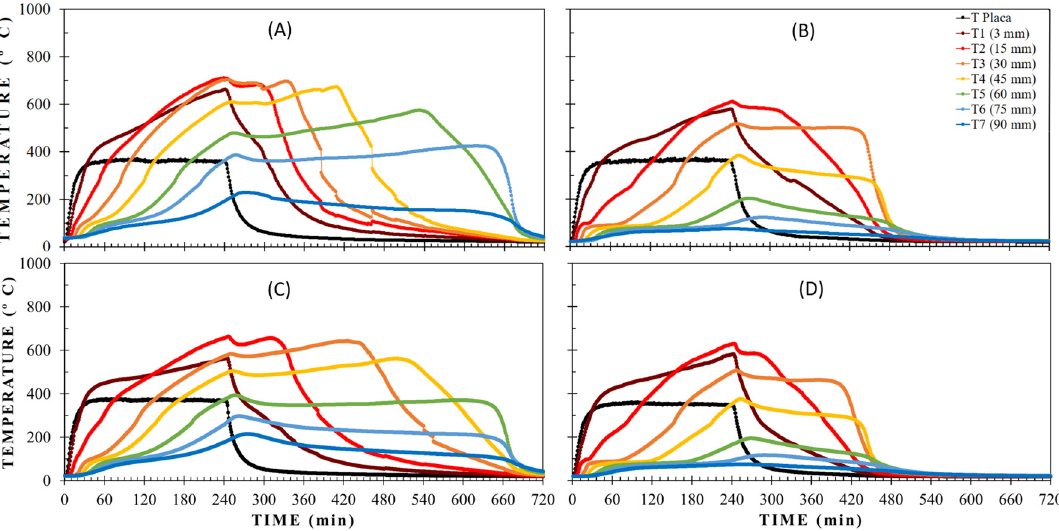
Figure 6. Temperature evolution of CP-Dried ( A ), CP-Wet ( B ), CP-Dried-V ( C ), and CP-Wet-V ( D ). Evaluating the sample’s middle-point for the corn powder graphs, the temperatures of CP-Dried and CP-Dried-V cases only reach the hot plate temperature at 3 h and 3 h and 47 min, respectively. However, the middle-point of the wet samples does not achieve the hot plate temperature, and they approximately reach 200 ◦